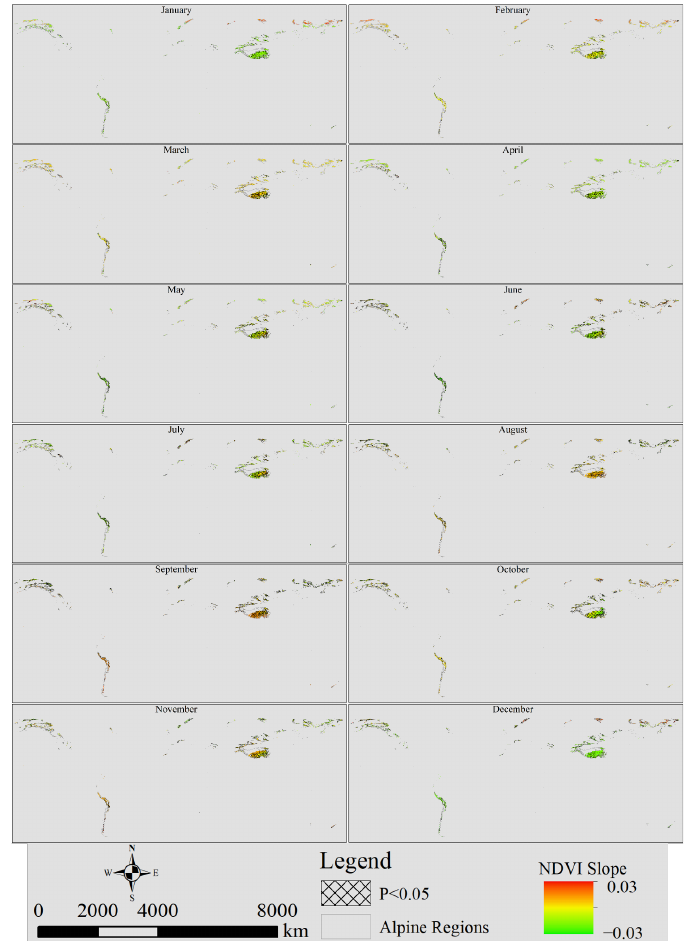
Figure 1. Vegetation change trend of global alpine regions from 1981 to 2015.